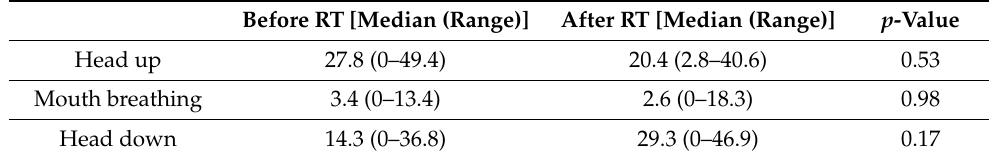
Figure 5. Changes in nasal planum temperature are shown before RT (T0), 30–120 min after RT (T1), 121–240 min after RT (T2), and 241–360 min after RT (T3). Thermal image data are presented as mean ± standard deviation (SD). * Indicates statistical significance (T0 vs. T2). Table 2. Behavioral changes before and after